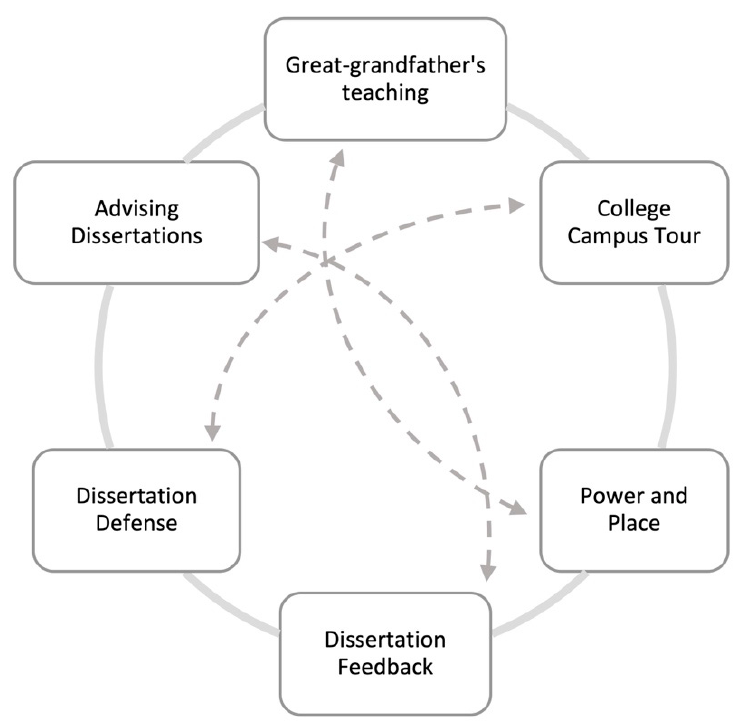
Figure 3. Cyclical continuum of stories.